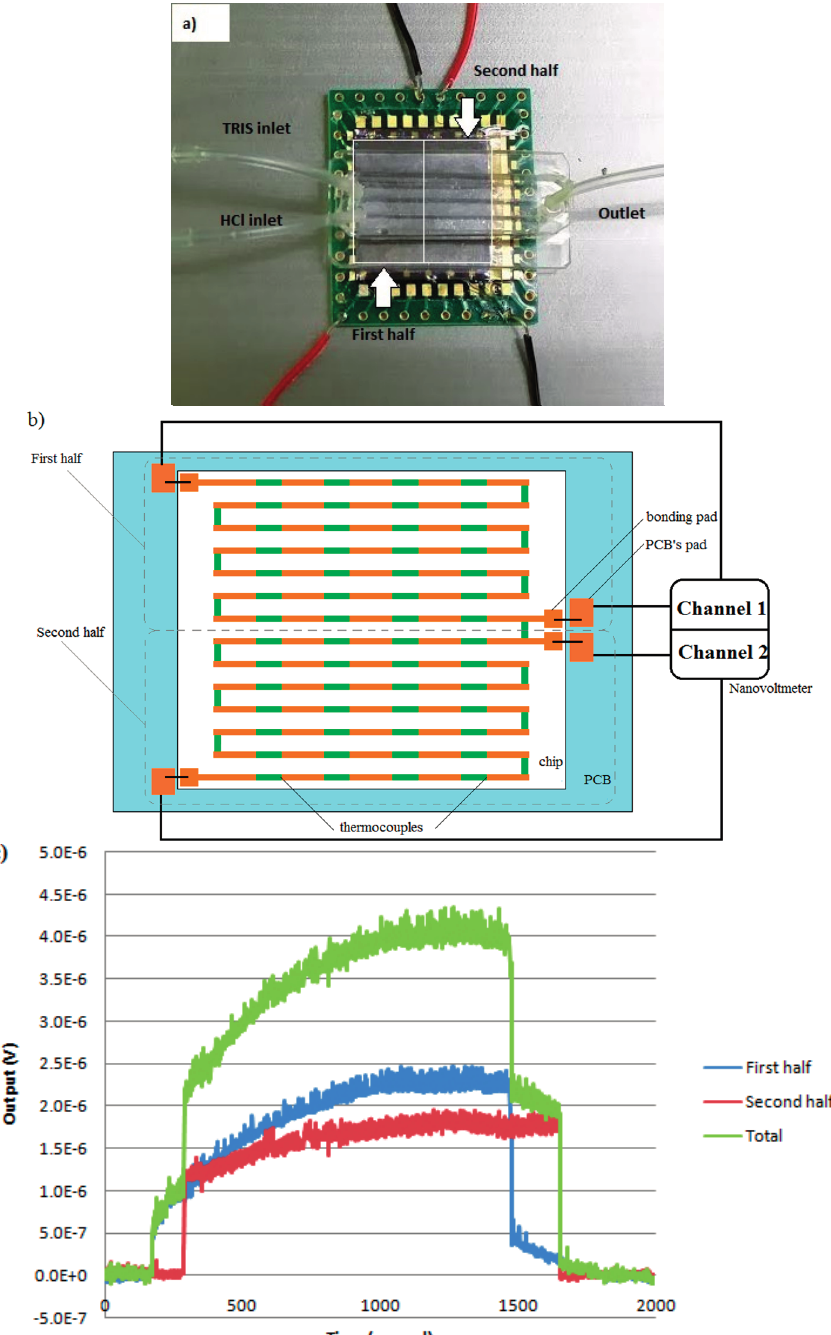
Figure 7. ( a ) Device is divided into 2 halves, each of them connected to an independent readout channel. ( b ) Illustration of the area-partitioning mechanism. ( c ) Data collected from the two